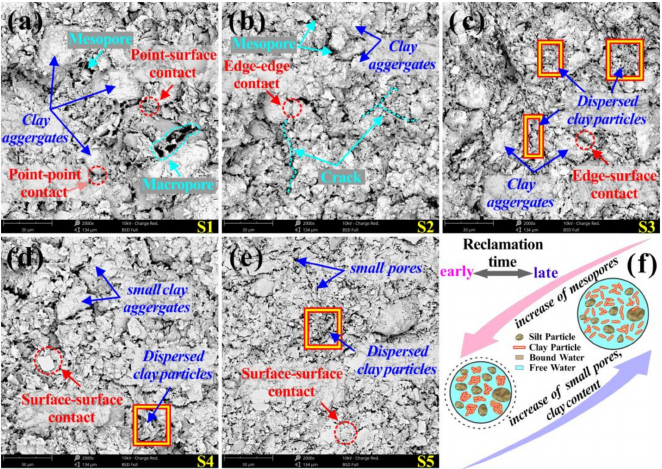
Figure 14. ( a – e ) Original SEM images of soil sample S1-S5; ( f ) Conceptual model of clay microstruc- ture in late reclamation area and early reclamation